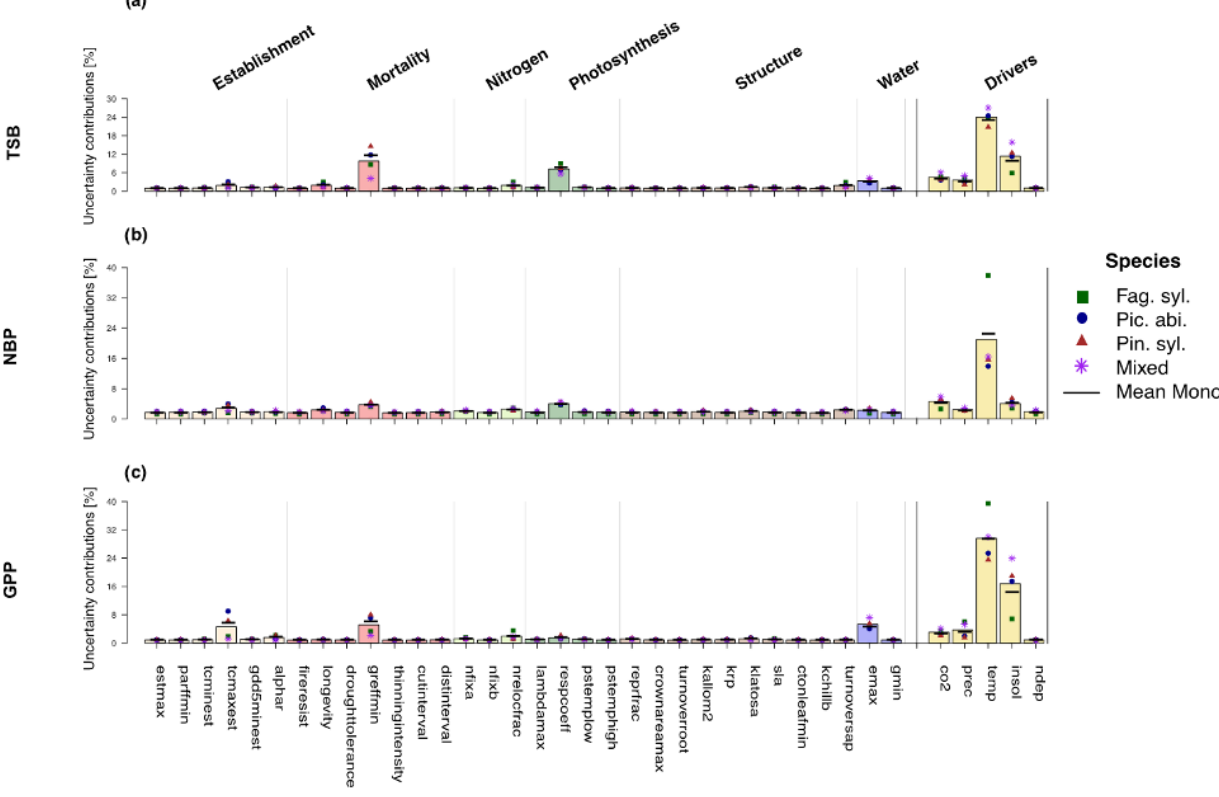
Figure A3. Results of the random forest uncertainty contributions. The uncertainties due to environmental drivers are higher than the uncer- tainties due to parameters compared to linear regression results, but the ranking of parameters is similar to linear regression results.